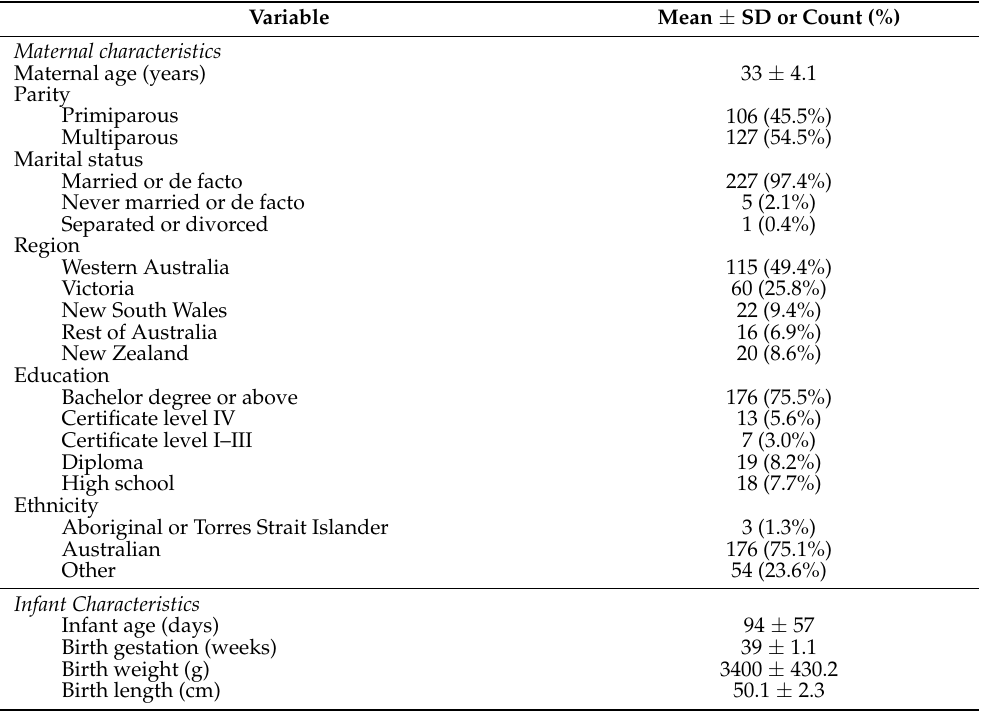
Table 1. Demographics and participant characteristics.